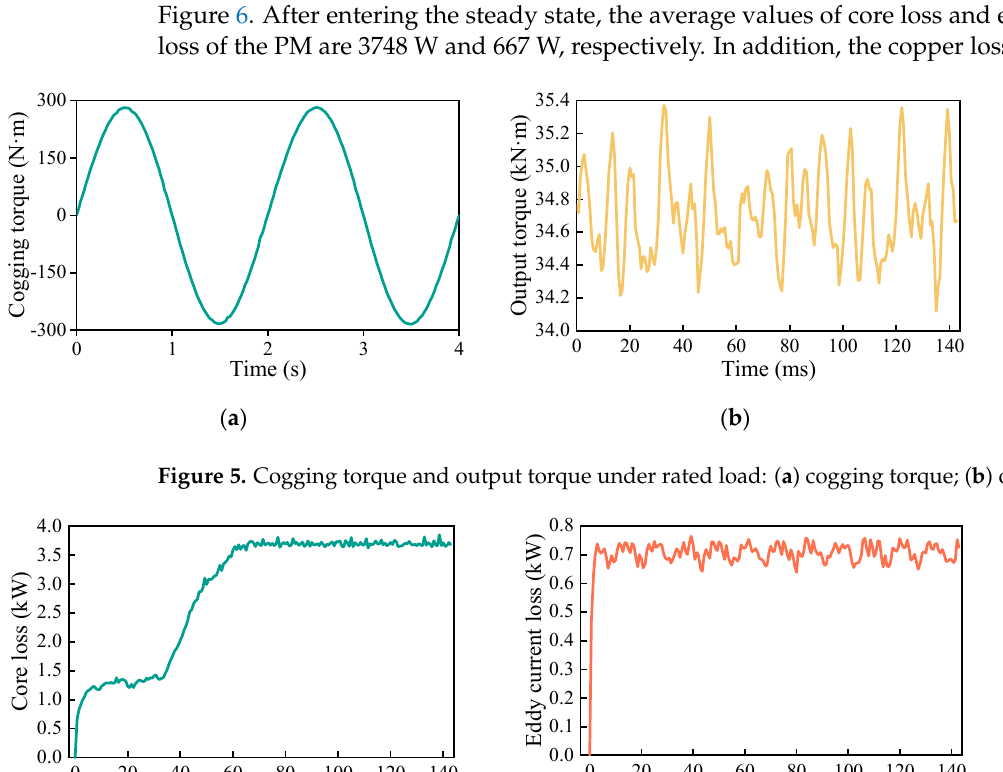
Figure 6. After entering the steady state, the average values of core loss and eddy current